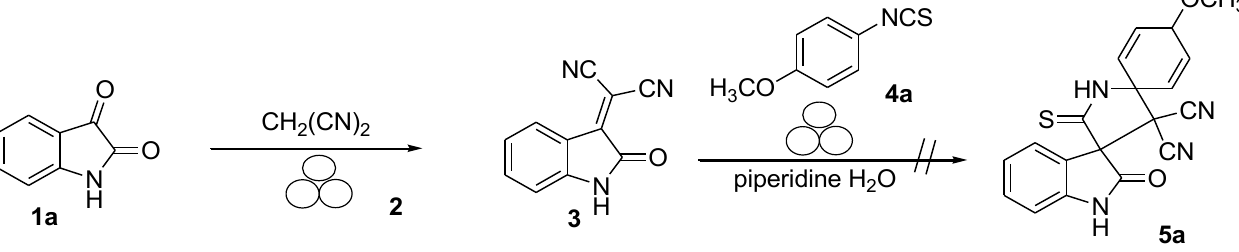
Scheme 4. Unsuccessful one step synthesis of spiroindole – pyrrolidine derivative ( 5a ) under mechanochemical activation.